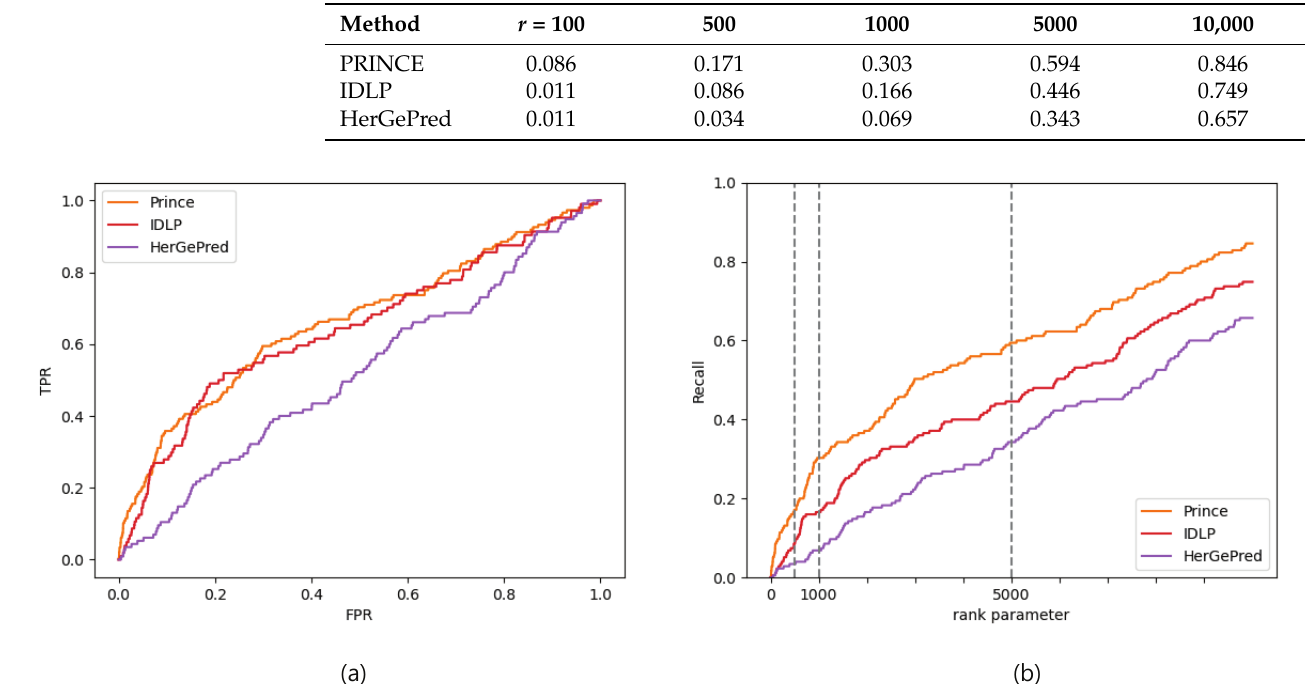
Figure 3. ROC ( a ) and recall ( b ) curves evaluated by gene ranks for disease-gene association predic- tion without known disease-associated genes.